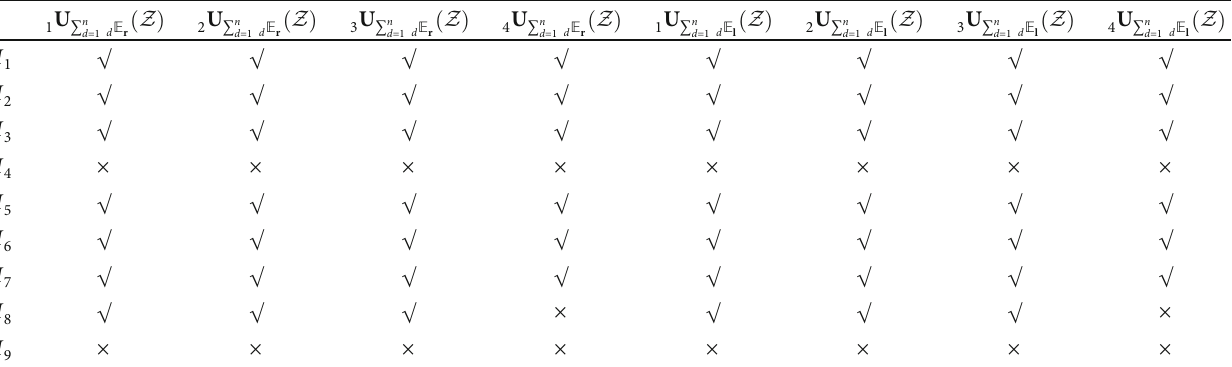
Table 2: Table for the upper